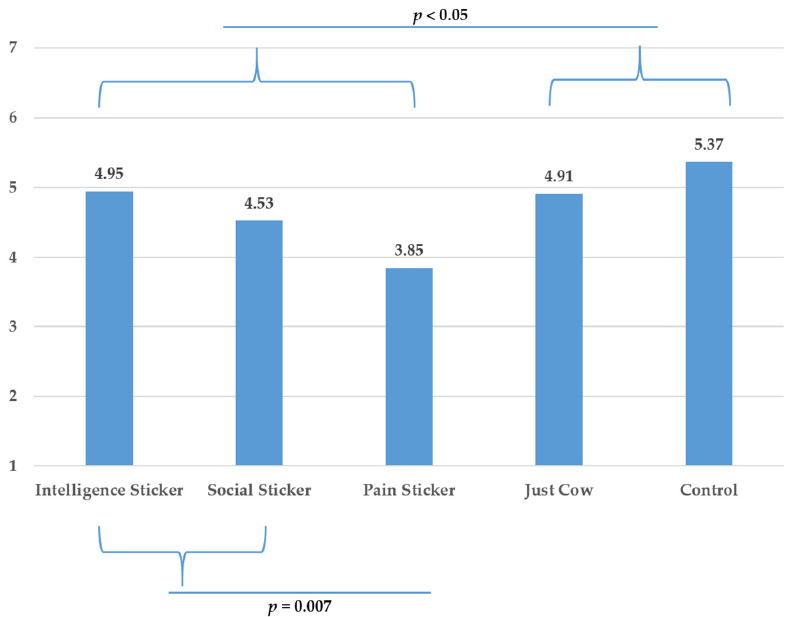
Figure 4. Purchase Intentions: Means for the different conditions and results contrast analyses (Study 1).